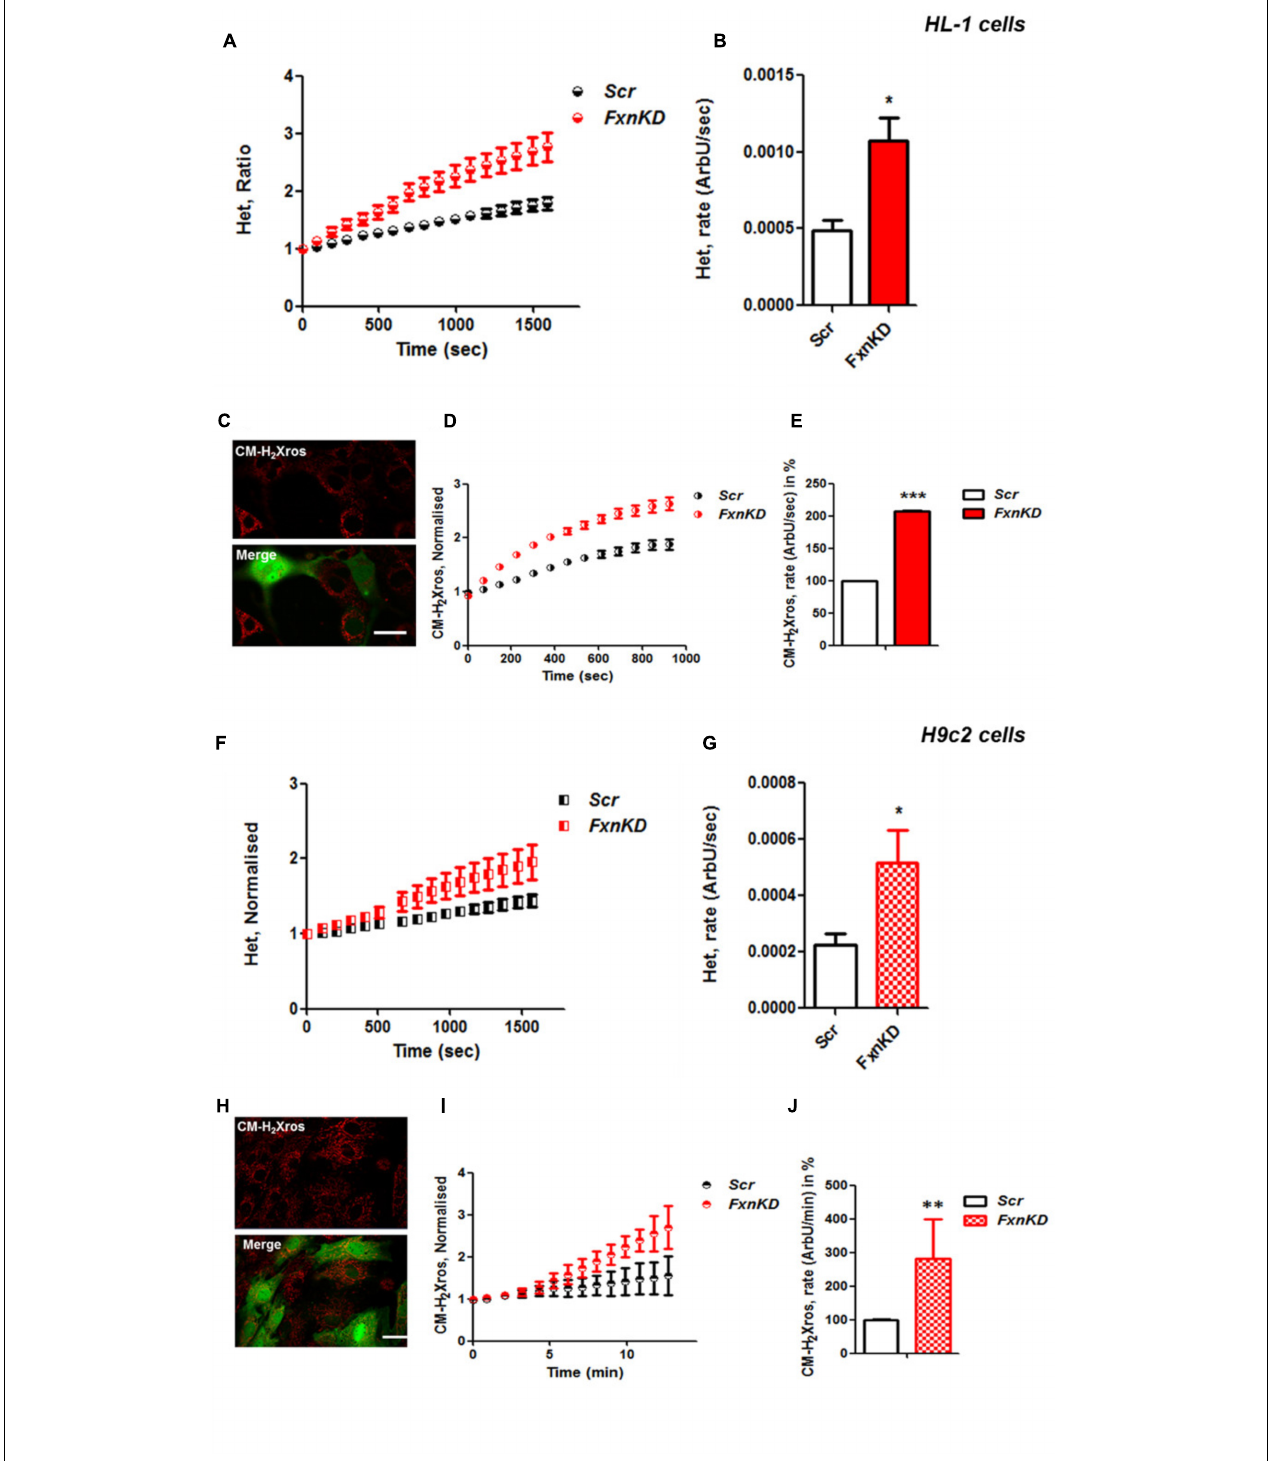
FIGURE 2 | Frataxin decrease causes oxidative stress in cardiomyocytes. (A,B) HL-1 cells, Scr and FxnKD, were loaded with 10 µ M dihydroethydium (Het) and imaged over time. (A) The kinetic curve show an increase of Het, meaning an increase of cytosolic ROS in FxnKD cells (red). (B) Confirmed by the rate of the dye ( ∗ p < 0.05). (C) Here it is shown the loading of the dye (red) and the transfected cells (green in the merge). (D,E) The kinetic curves and the histogram represent the increase of mROS measured with 1 µ M CM-H2Xros. Mitochondrial ROS were significantly increased in FxnKD ( ∗∗∗ p < 0.0005). (F,G) We report the results of cytosolic ROS in H9c2 cells, that also showed a relevant increase in FxnKD ( ∗ p < 0.05). (H–J) Here we report similar mROS measurements in H9c2 cells ( ∗∗ p < 0.005). Scale bar (20 mm).